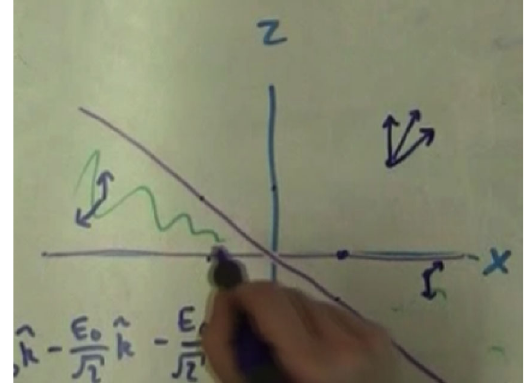
FIG. 8. Anne ’ s electric field vector map after determining the electric field in all four regions of interest.